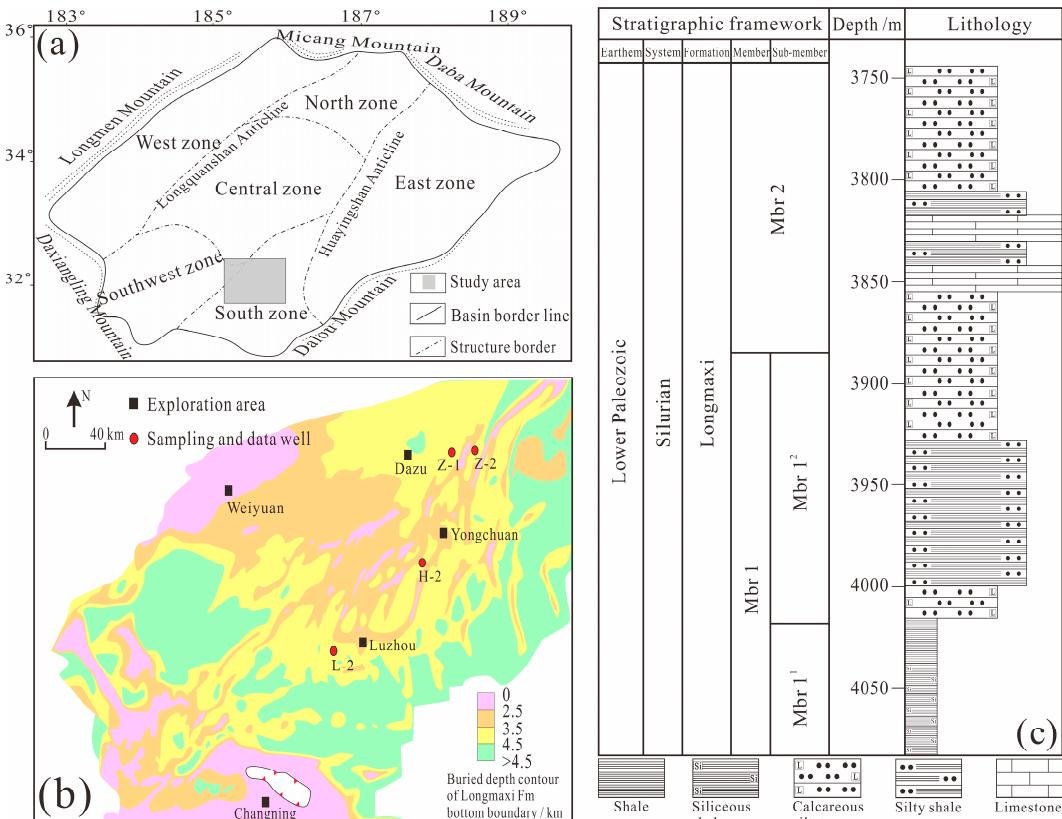
Figure 1. ( a ) Structure division of Sichuan Basin and the location of the study area; ( b ) geological map of the southern Sichuan Basin, showing the present-day burial depth of the Silurian Longmaxi Fm shale and the locations of sampling and data wells; ( c ) stratigraphic column of the Lower Silurian Fm of Well H-2 in the study area.